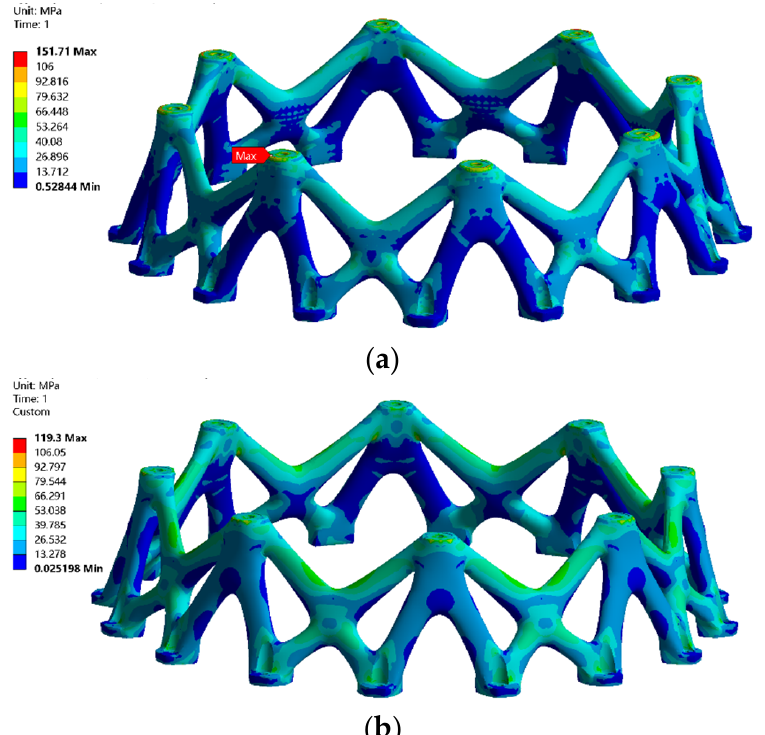
Figure 13. VonMises stress distribution: ( a ) detailed model analysis results; ( b ) homogeneous model analysis results.